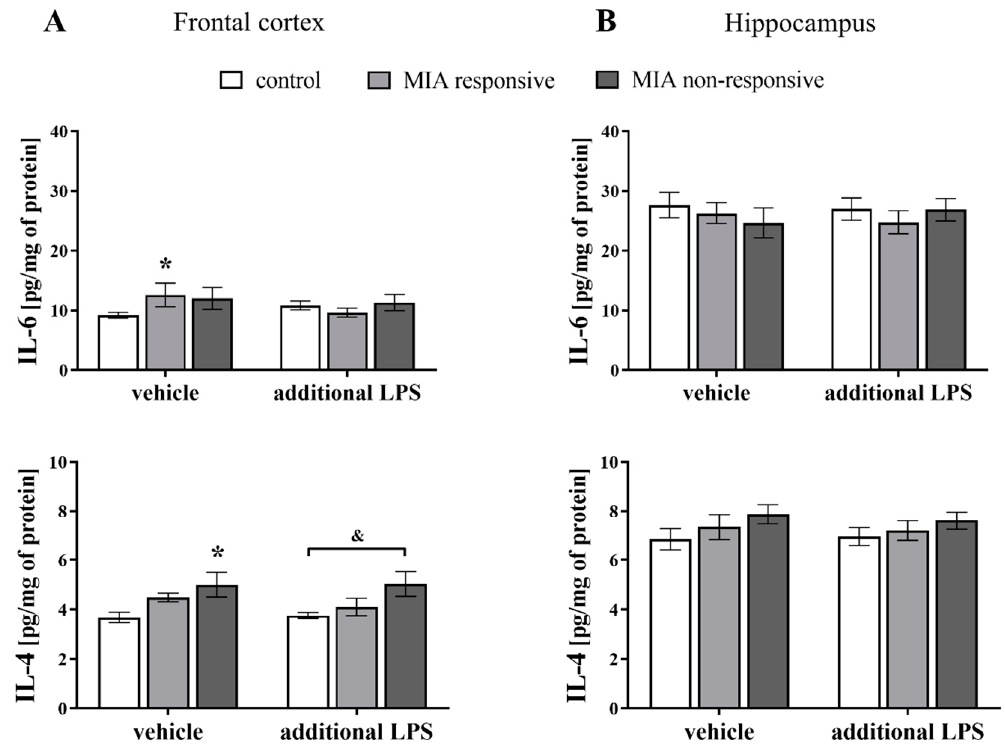
Figure 11. The effect of MIA and the additional acute challenge with LPS on the protein levels of the pro-inflammatory cytokine IL-6 and the anti-inflammatory cytokine IL-4 in the frontal cortices ( A ) and hippocampi ( B ) of male Sprague-Dawley offspring at PND120. n = 4–10 in each group. The results are presented as the means ± SEM. * p < 0.05 vs. control + vehicle, & p < 0.05 vs. control + LPS.